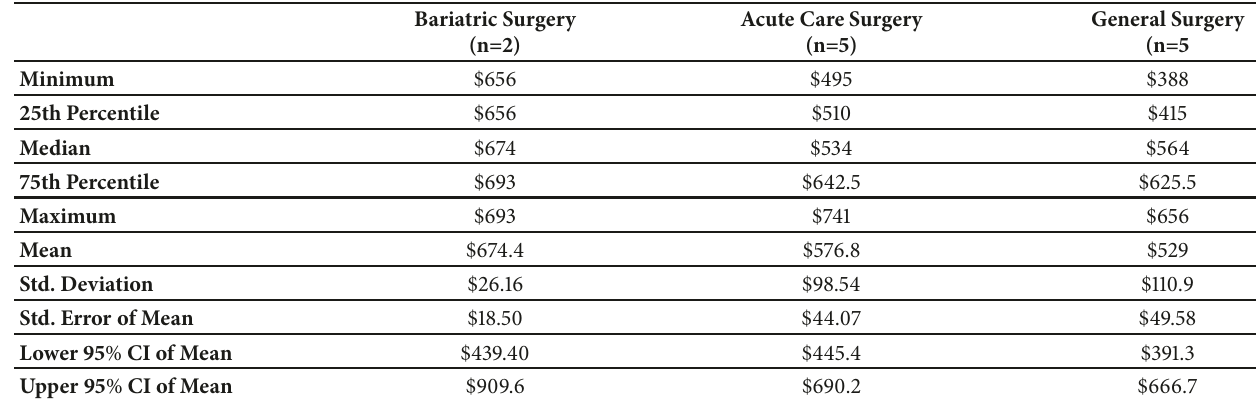
Table 1: Supply cost analysis.